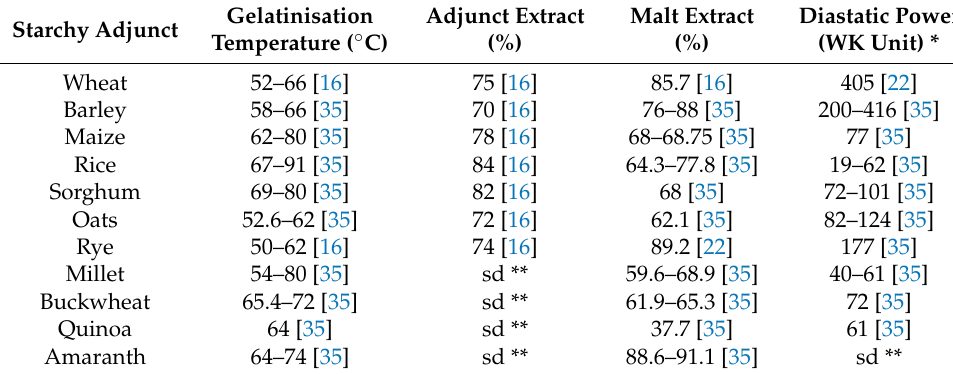
Table 3. Characteristics of starchy adjuncts used in